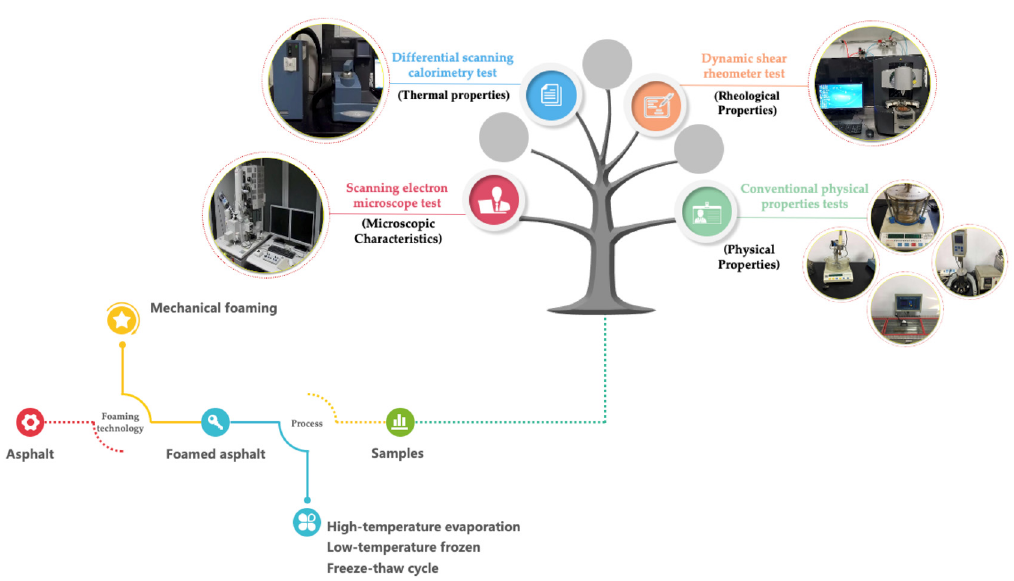
Figure 1. Technical route of this article.